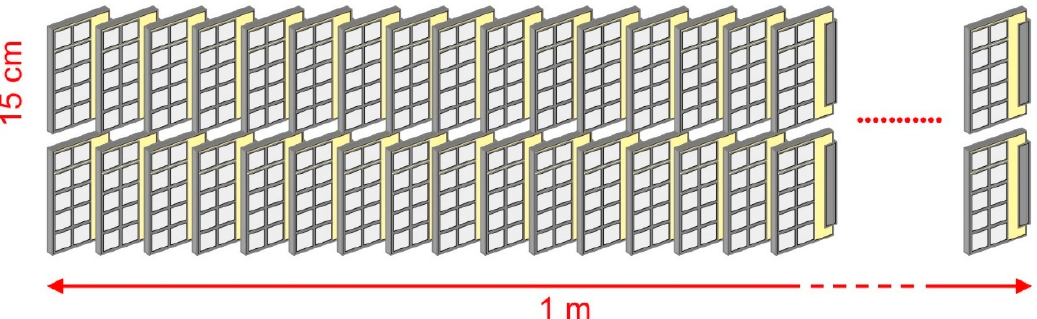
Figure 14. The full width of the Magnex focal plane (1 m), will be covered by 41 towers rotated by about 35° with respect to the vertical axis to compensate the tilting angle of the focal plane with respect to the dipole magnet output.